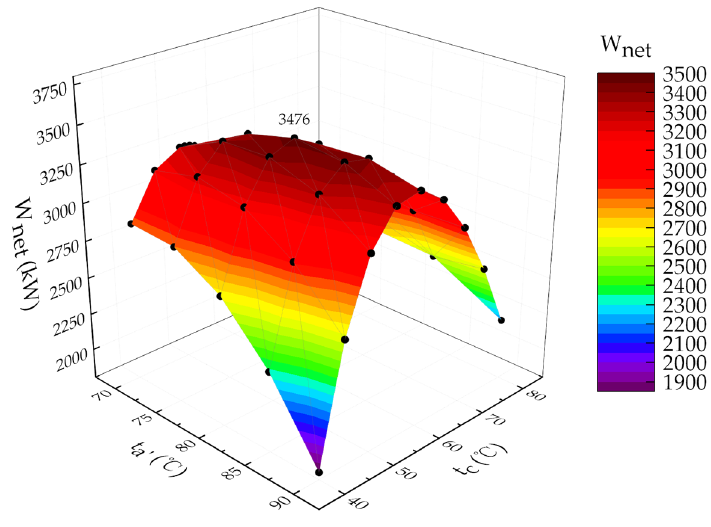
Figure 6. Influence of t a’ and t c on net output power of CD-ORC.